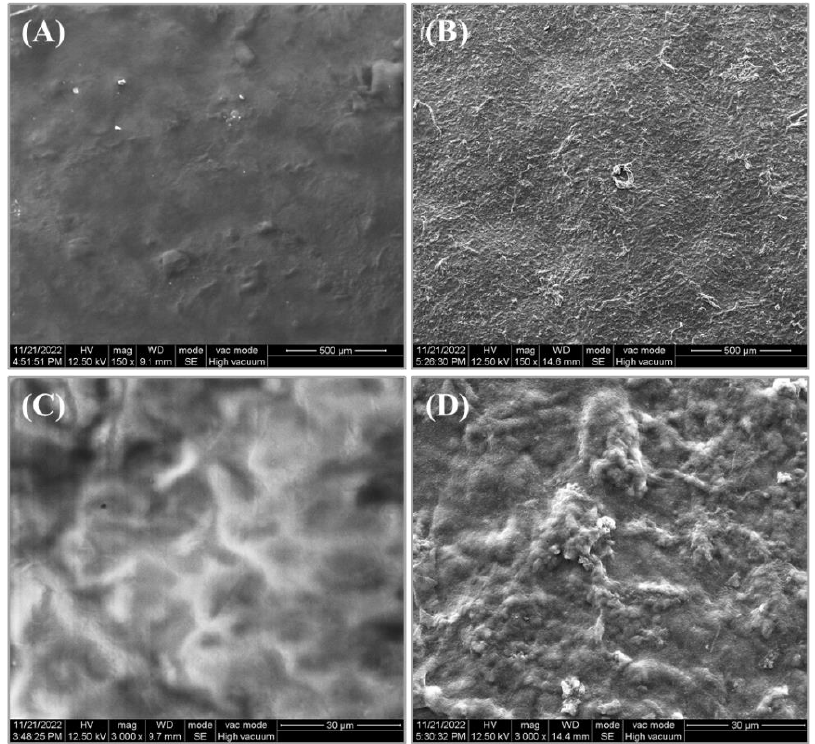
Figure 5. Surface microstructure of CMC/WPI - AF membranes as revealed by scanning electron microscopy (SEM). SEM images of CMC/WPI - AF membranes with CMC:WPI - AF mass ratios of 1:1 ( A , C ) and 1:2 ( B , D ). ( A , B : magnification = 150×; scale bar = 500 μm; C , D : magnification = 3000×; scale bar = 30 μm).